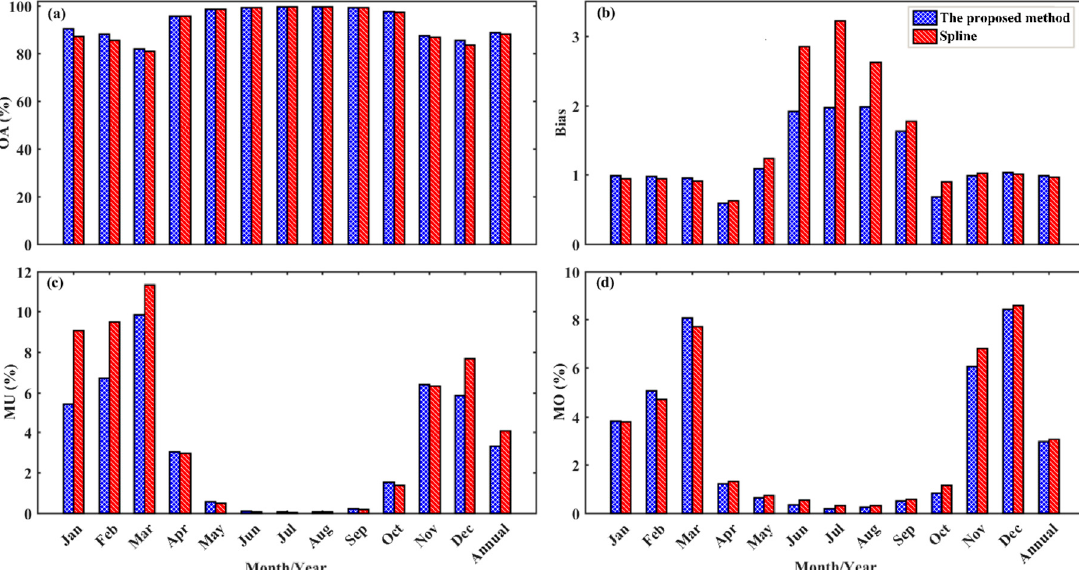
Figure 15. Monthly/annual variation of four validation indices for the proposed method and the existing cubic spline temporal interpolation approach (spline).